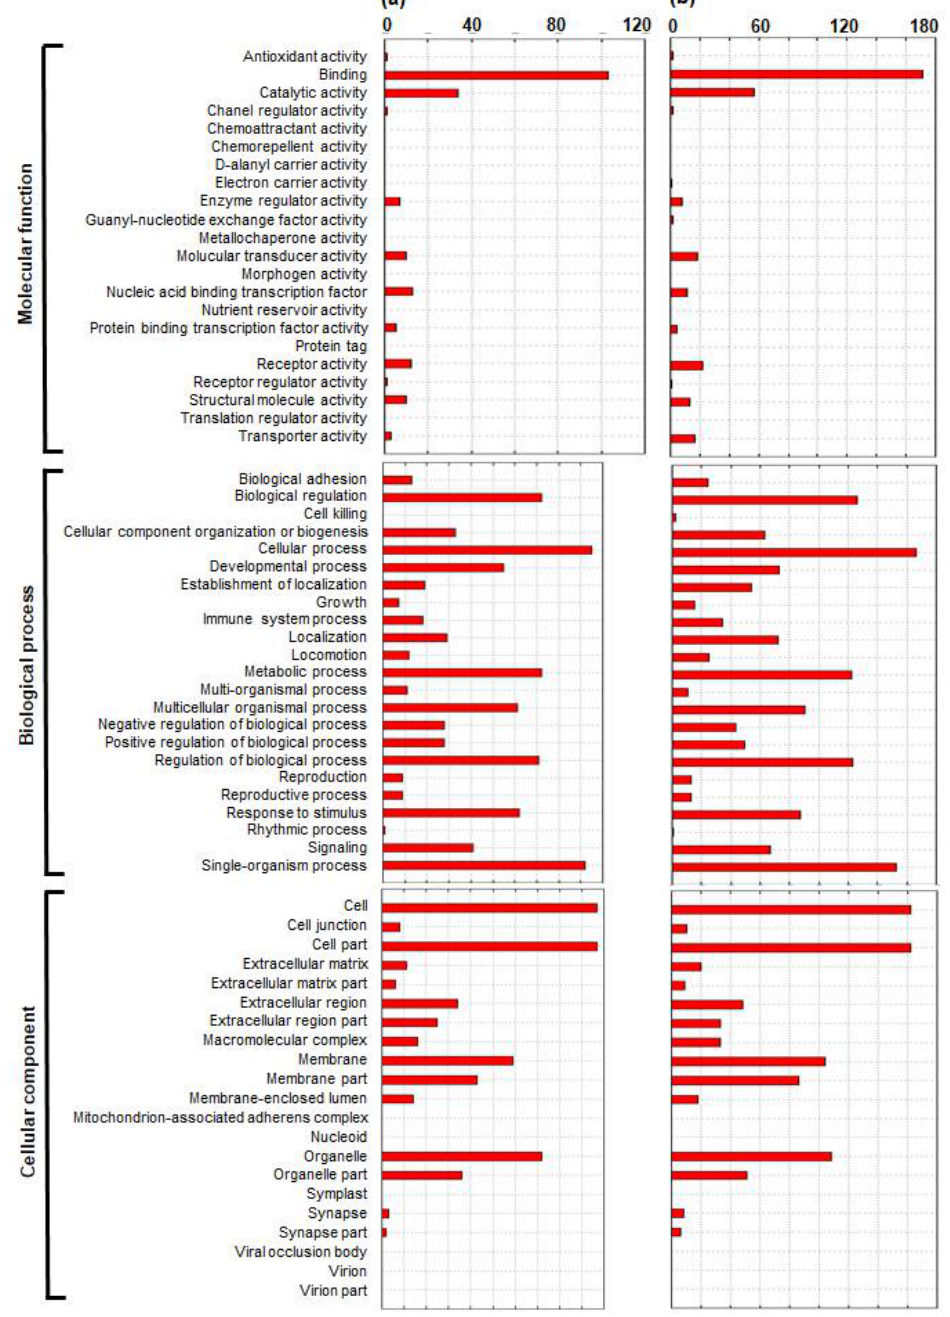
Figure 2. Histogram of gene ontology (GO) classification. GO functional enrichment analysis of differentially expressed gene (DEGs) ( a ) in YD-8/CIS relative to YD-8 and ( b ) in YD-9/CIS relative to YD-9. The functions of genes identified in three main classifications: molecular function, biological process, and cellular component. The x -axis represents the number of genes and the y -axis represents the ontology categories. Using a minimum log2 fold change of 2 and a maximum −log10 adjusted q -value of 0.05 as the cutoffs, genes with significant differences in expression between the two